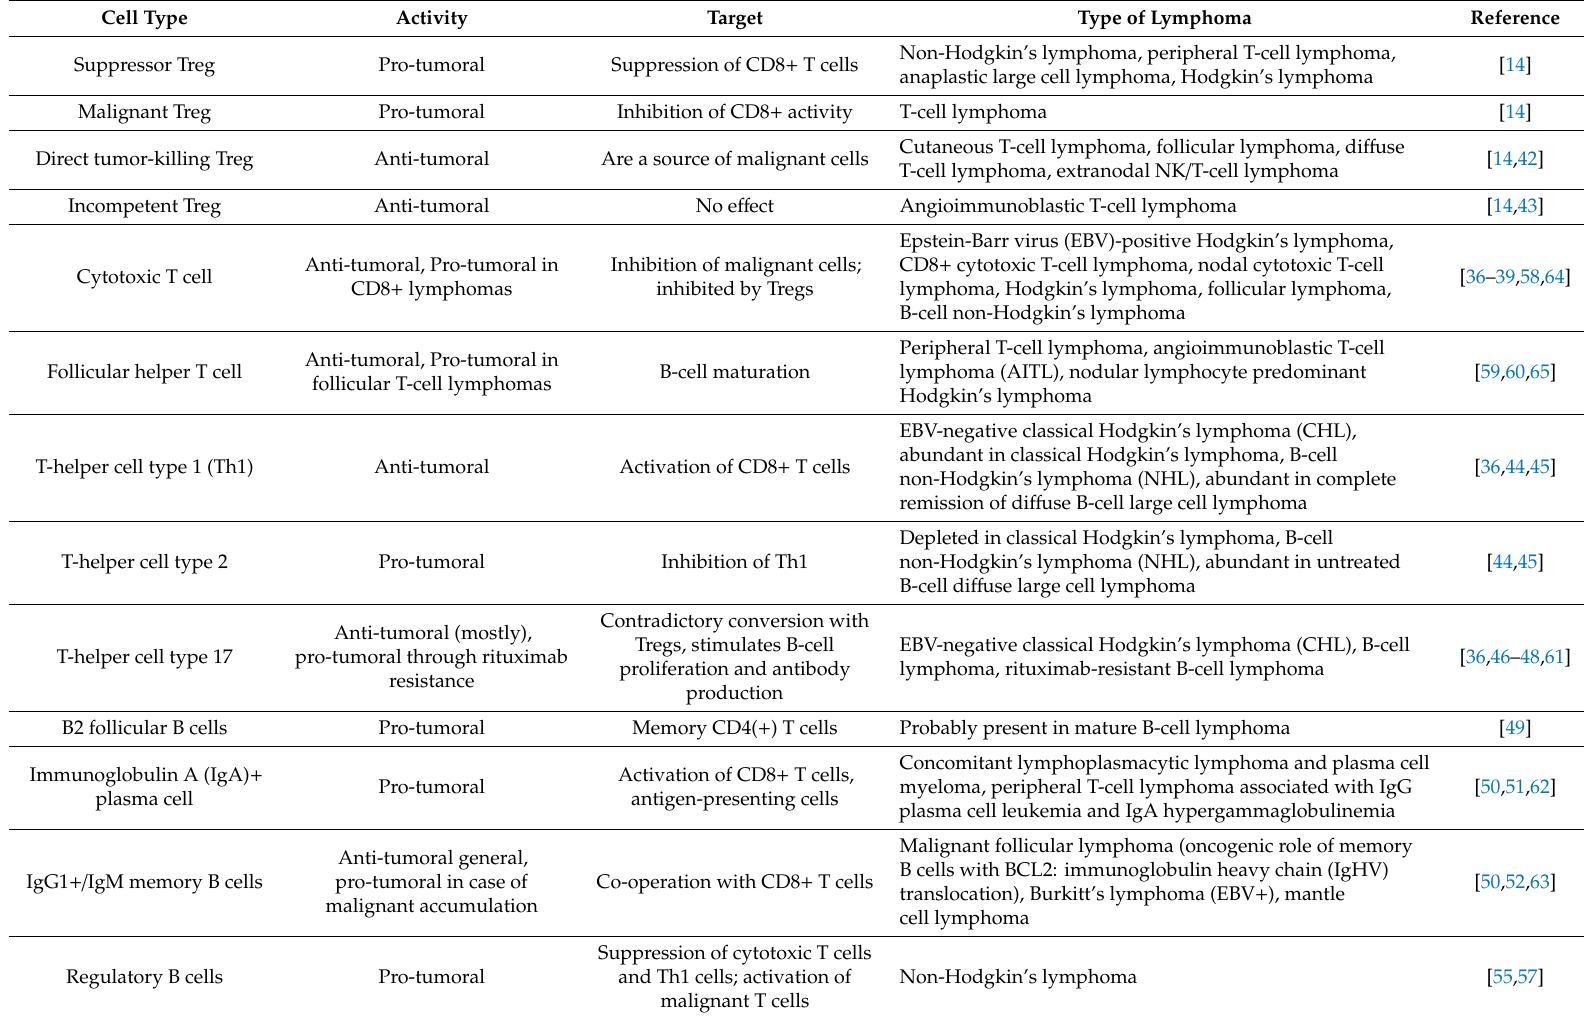
Table 1. Pro- / anti-tumoral immune cells in the tumor microenvironment of T-cell or B-cell